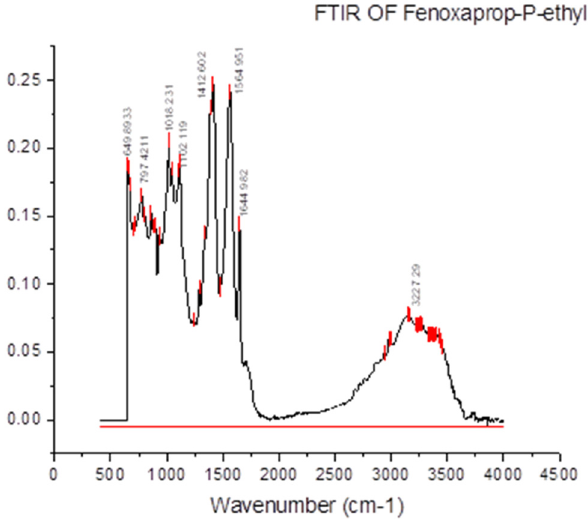
Figure 6: UV - Vis absorption spectrum of chitosan - based NPs of fenoxaprop - p -